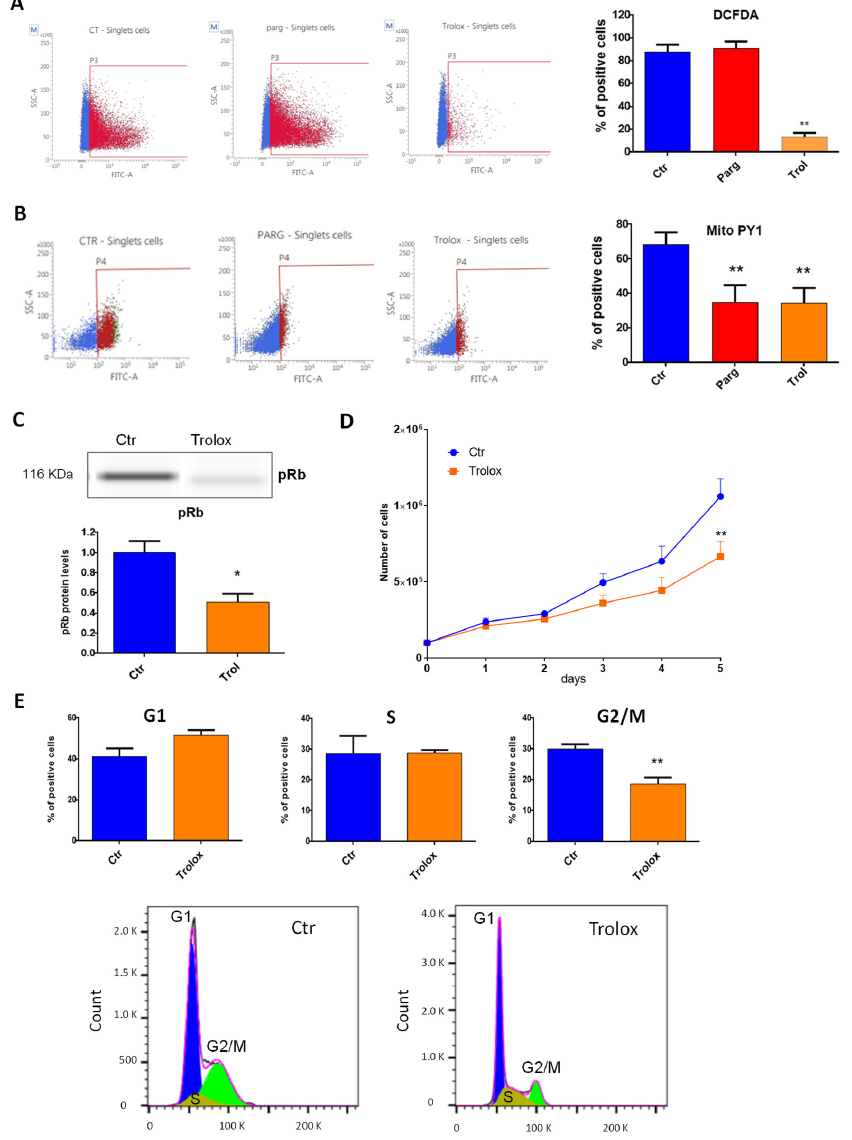
Figure 4. ROS content and role in AY27 cells. ( A , B ) ROS content was measured with either the DCFDA probe (2 ′ ,7 ′ _dichlorofluorescin diacetate) (N = 3) ( A ) or the MitoPY1 probe (Mitochondria Peroxy Yellow 1) (N = 4) (B) by flow cytometry in AY27 cells treated or not with pargyline or Trolox for 72 h. ( C ) The expression of phospho-Rb in AY27 cells after Trolox treatment compared to the control cells was measured by WES, N = 8. ( D ) Proliferation curve of AY27 cells cultured in standard media supplemented or not with Trolox, N = 5. ( E ) The number of AY27 cells in each phase of the cell cycle was examined by flow cytometry with propidium iodide DNA staining (N = 5). * p < 0.05, ** p < 0.01 compared with Ctr cells. All the values are expressed as mean ± SEM.